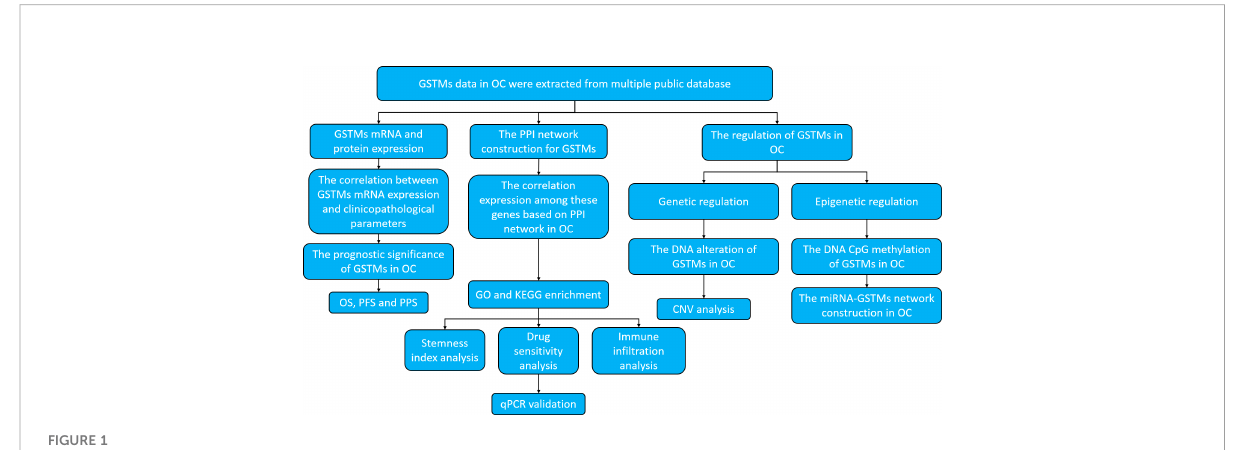
FIGURE 1 Work fl ow of the